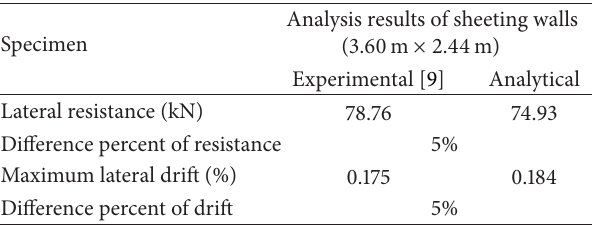
Table 5: Comparison of results, experimental and